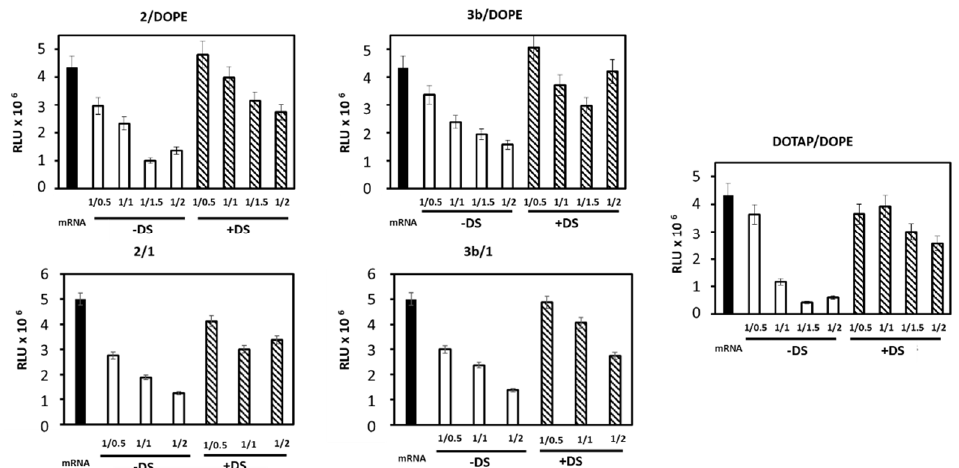
Figure 6. In vitro transcription of mRNA-Luc LX. mRNA-Luc (0.2 µg) (black bar) free or complexed with the indicated liposomes at various mRNA/L ratio was incubated (white bar) in the absence or (hacked bar) the presence of 90 µM DS for 1 h. For 2 / 1 and 3b / 1 LXs the lipid molar ratio was 1/1; for 2 / DOPE and 3b / DOPE LX it was 2/1 and it was 1/1 for DOTAP / DOPE . Next, samples were mixed with the TNT Quick Coupled Transcription/Translation Systems Kit (Promega). After 1 h 30 min incubation at 30 °C, the luciferase activity was measured and expressed as relative light unit (RLU).